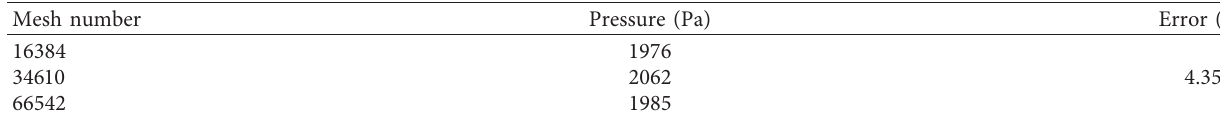
Figure 1: The meshing of drilling bit meshing. Table 1: The details for the grid independence study.